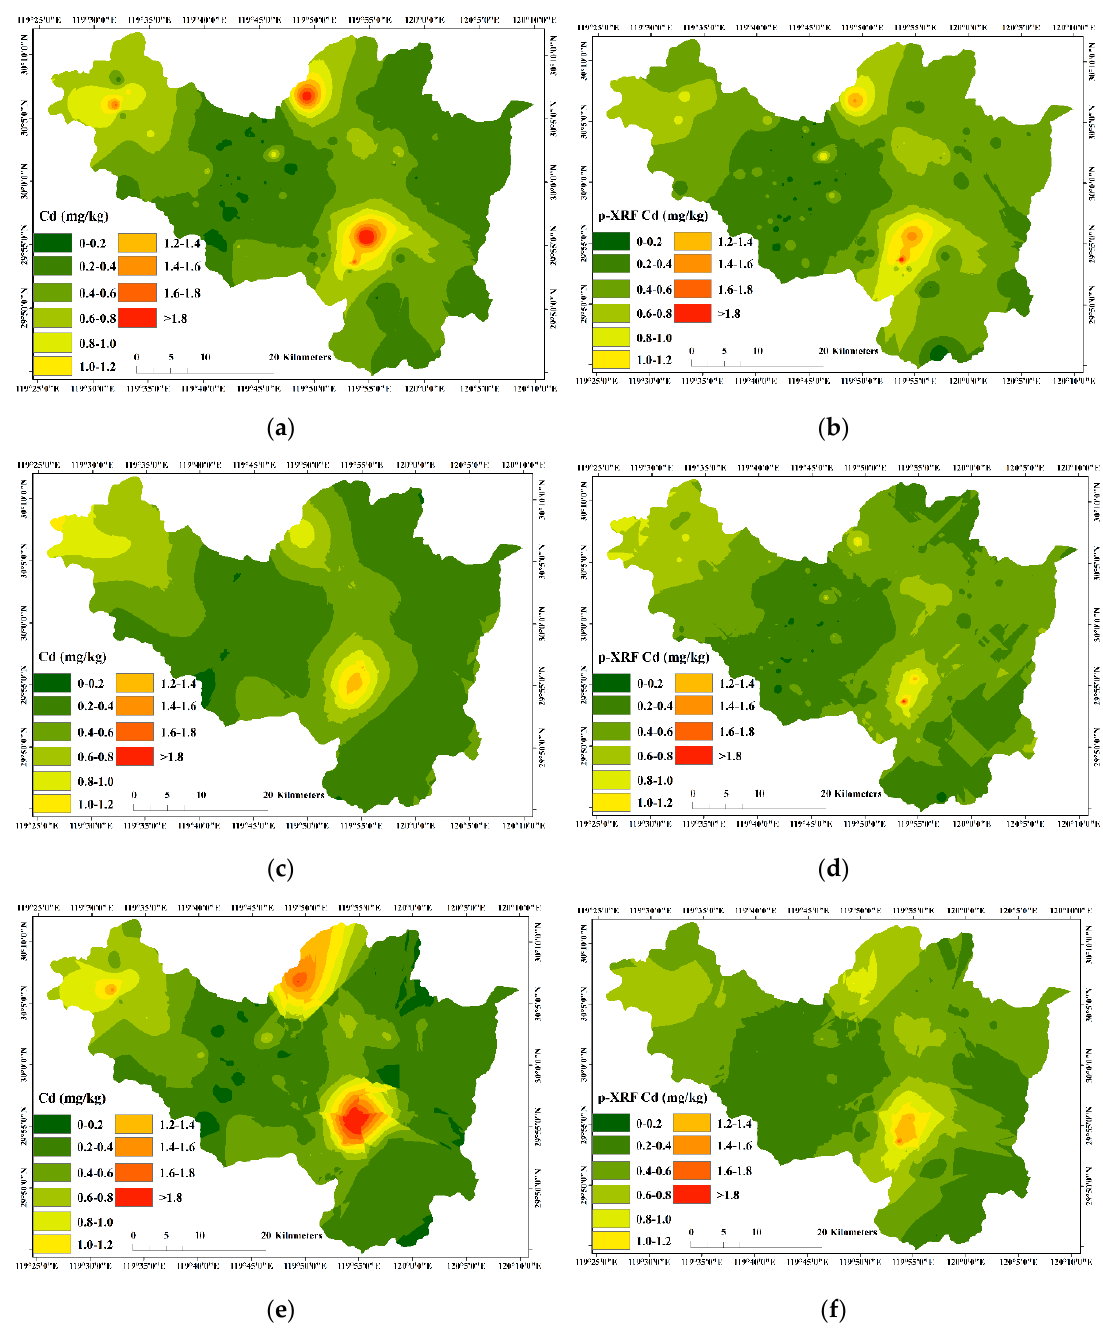
Figure 5. Maps of Cd content measured by LC-ICP-MS (left column) and p-XRF (right column) using IDW ( a , b ), OK ( c , d ), and EBK ( e , f ) geostatistical methods.